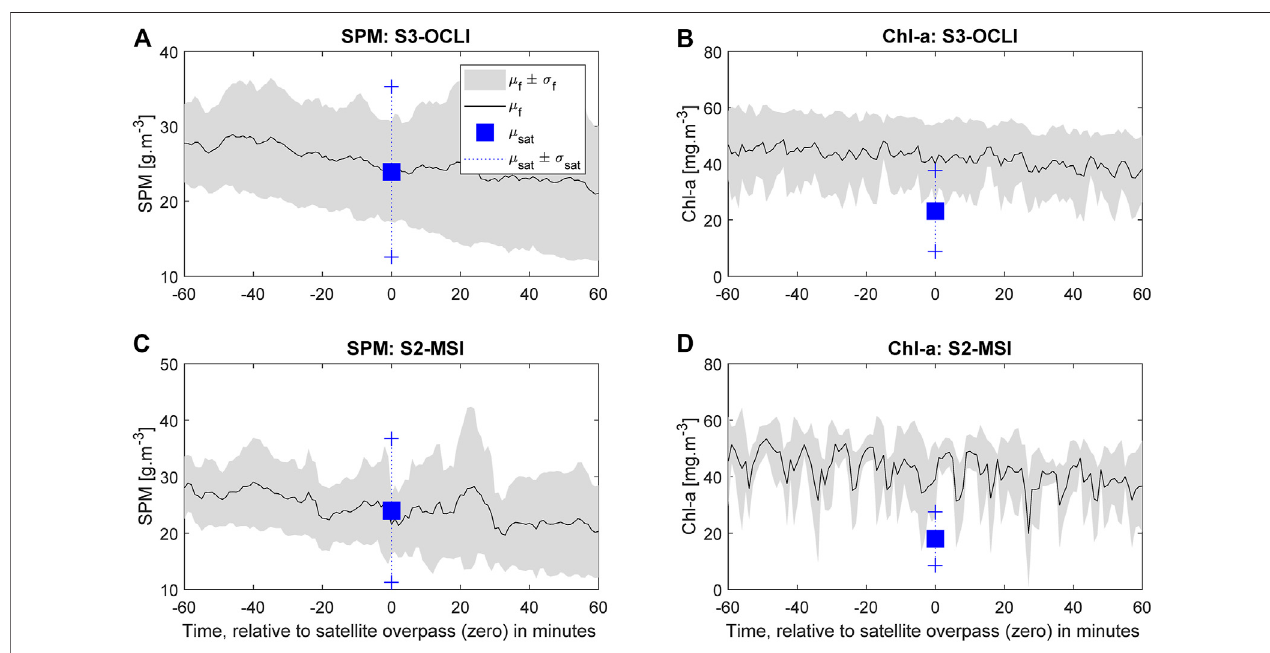
FIGURE 5 | Semivariograms of in-situ measurements around the satellite overpass for S3-OLCI (A) , (B) and S2-MSI (C) , (D) . Solid lines depict average values, whereas shaded areas represent the variability as ± standard deviation. The dotted line represents the similarity condition of Eq. 8 set to one for illustration.